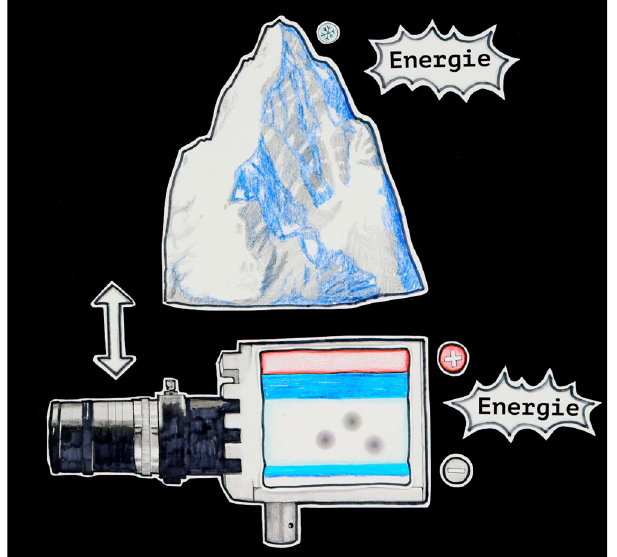
FIG. 4. Screenshot from an explanatory video: to teach students the functioning of single photon detectors at an appropriate level, we have developed an analogy to the formation and departure of snow avalanches [53]. Step by step, the video guides students through the correspondences of our analogy. In this way, technical terms such as dark count event or dead time become accessible to students. We consider the basic knowledge of such terms to be a necessary prerequisite to understanding experiments with heralded